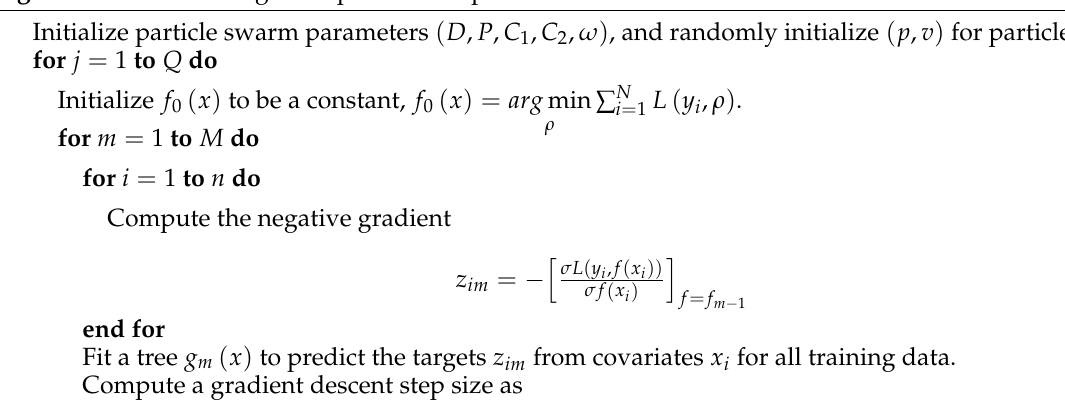
Algorithm 1 The training and optimization process of the PSO-GBDT